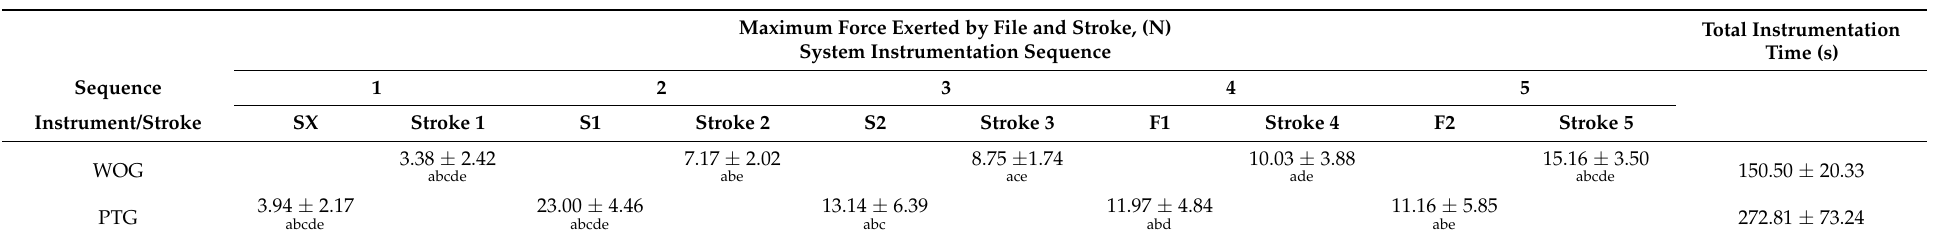
Table 3. Maximum exerted forces and instrumentation duration by engine-driven endodontic instrumentation